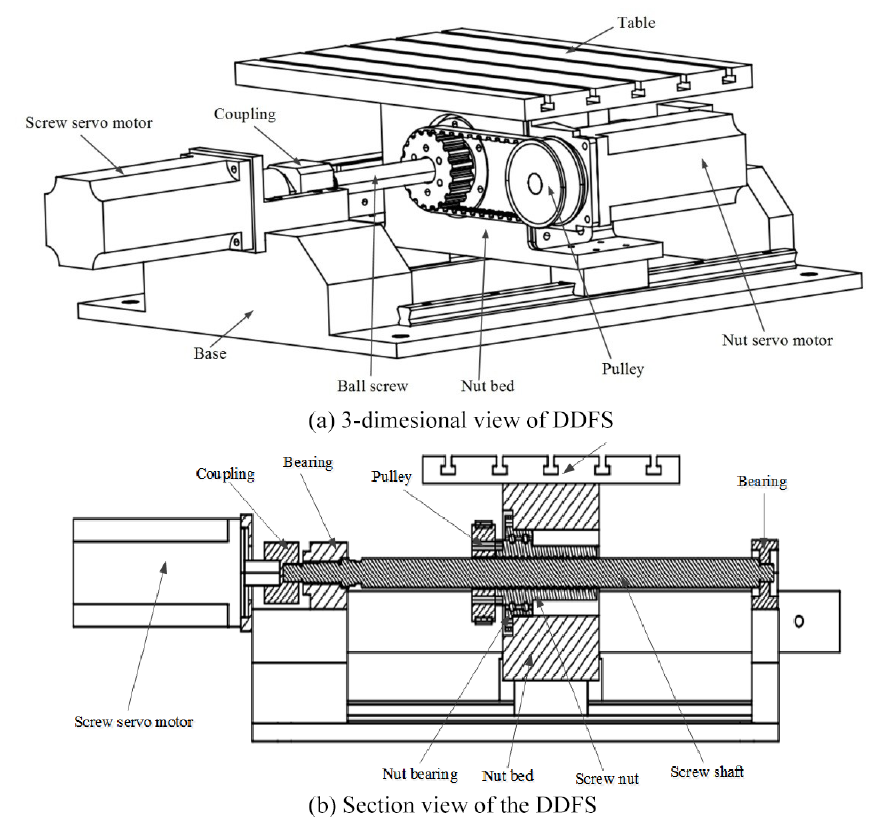
Figure 1. The DDFS structure.